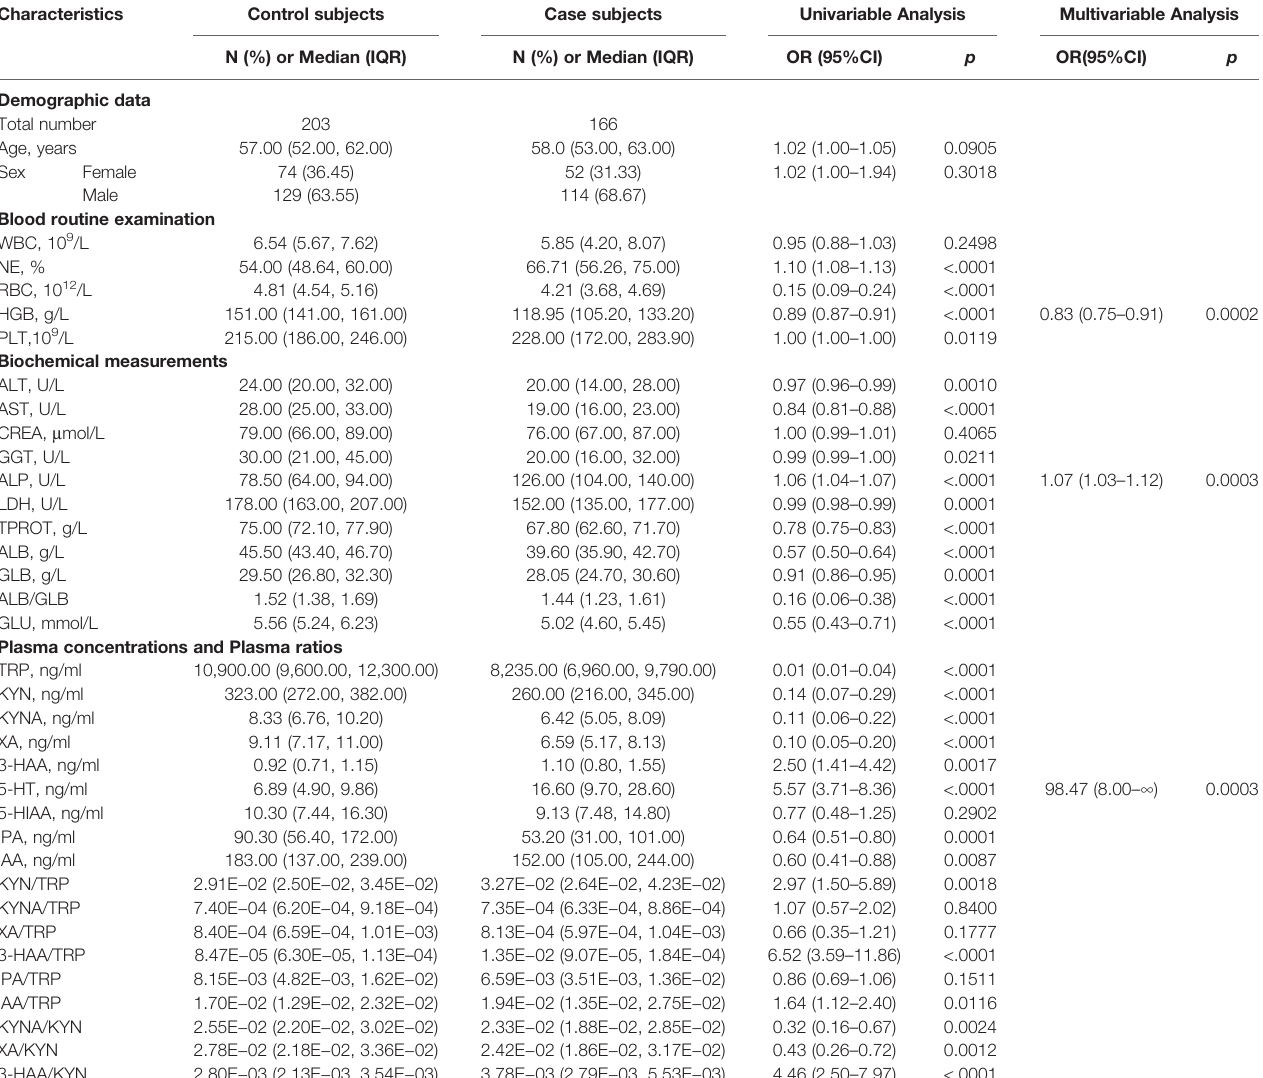
TABLE 1 | Associations of metabolites and baseline data with susceptibility